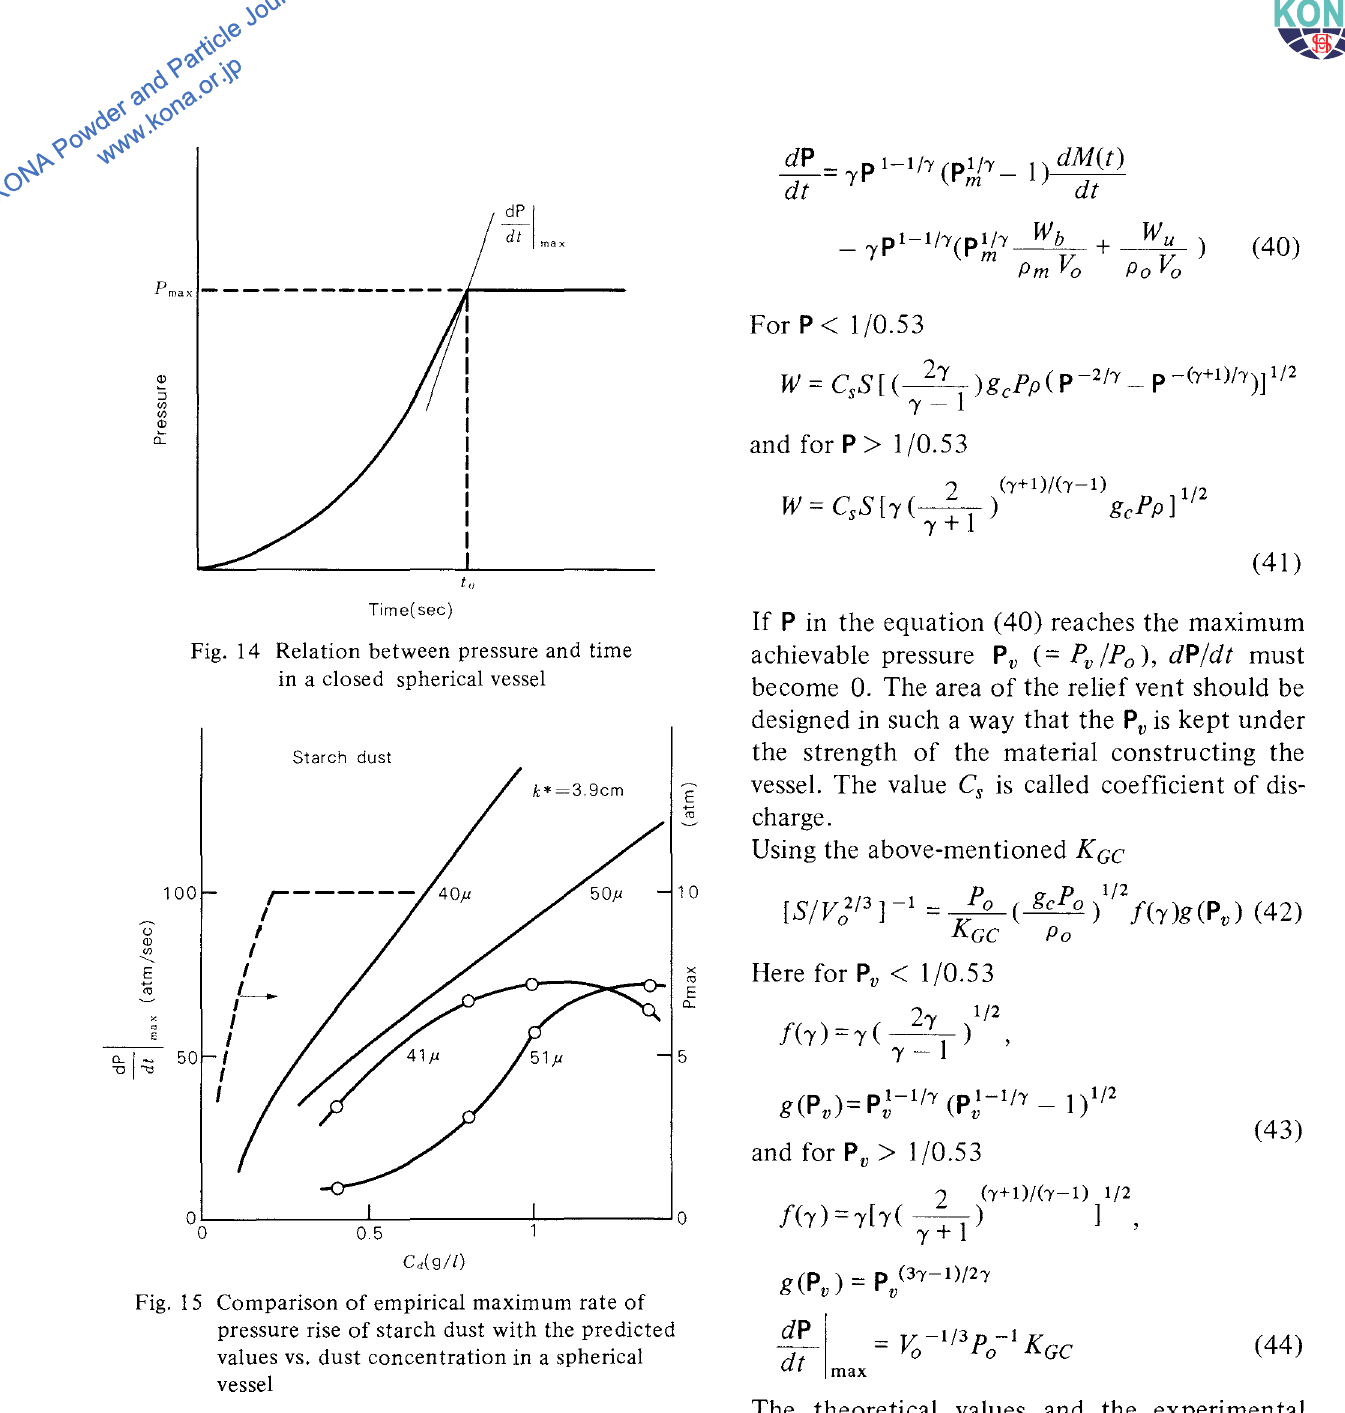
Fig. 15 Comparison of empirical maximum rate of pressure rise of starch dust with the predicted values vs. dust concentration in a spherical